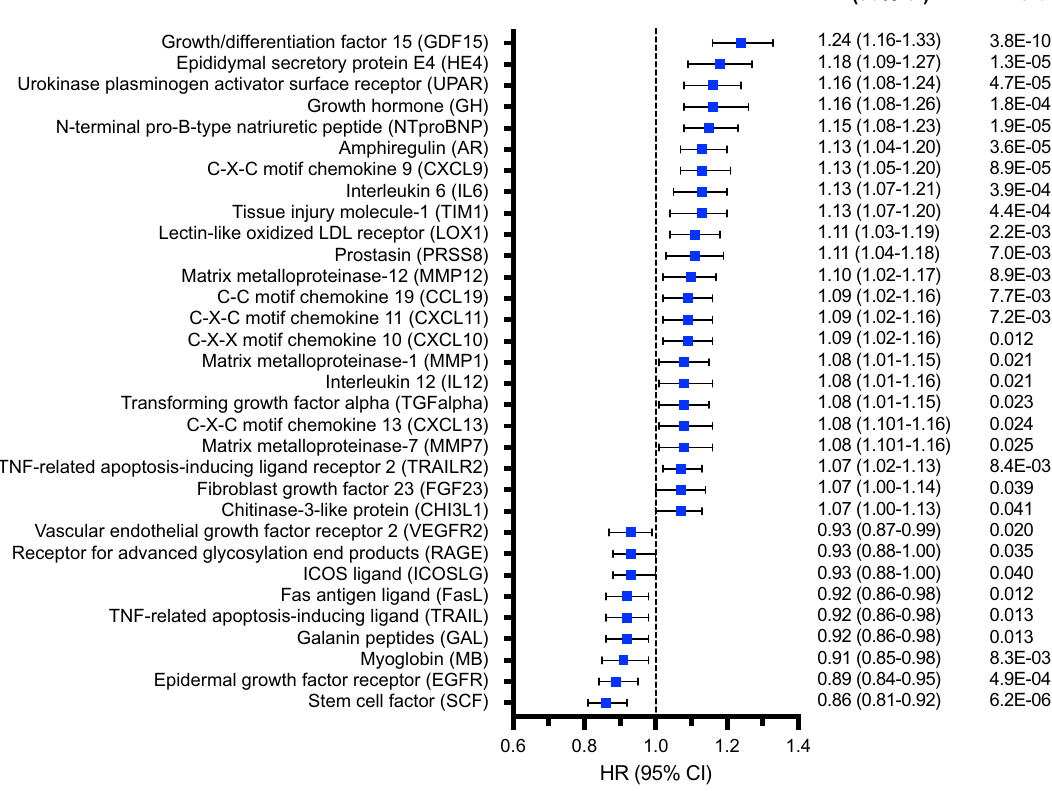
roni correction, eight proteins remained significantly associated with all-cause mortality (Fig. 2; Table 2). These included amphiregulin (AR), C-X-C motif chemokine 9 (CXCL9), epididymal secretory protein E4 (HE4), growth hormone (GH), growth/differentiation factor-15 (GDF15), N-terminal pro-B-type natriuretic peptide (NTproBNP), stem cell factor (SCF), and urokinase plasminogen activator receptor (UPAR). Compared to a clinical model (i.e. with established risk factors only) all identified proteins improved discrimination of all-cause mortality as assessed by the C-statistic and comparing model discrimination using the LR test (all P < 0.001). In